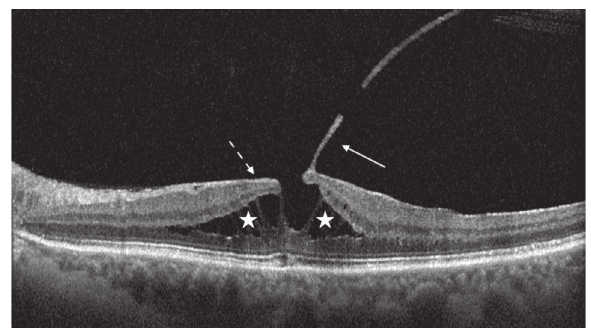
Figure 2: An epiretinal membrane associated with foveoschisis in its SD-OCTappearance. The white stars show the foveoschisis. The arrows show the presence of an adherent epiretinal membrane (dashed line) and vitreous cortex (continue line).